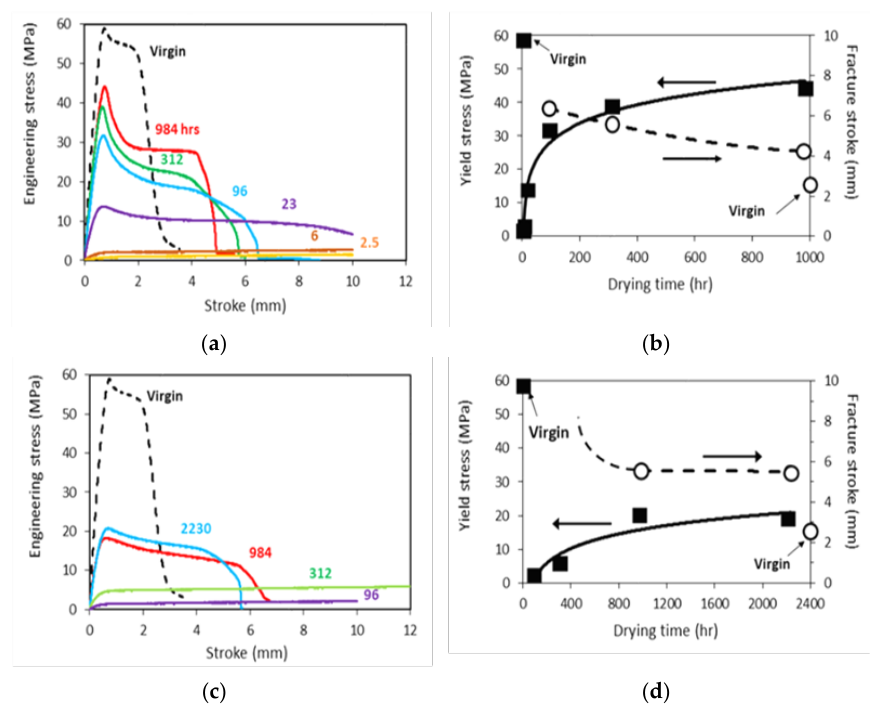
Figure 4. Mechanical test results for dog-bone specimens after immersion in acetone for 40 min